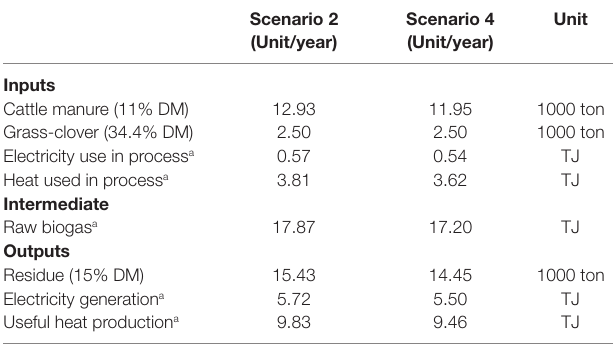
TaBle 7 | inputs and outputs from the biogas production process for the entire system of 1000 ha.